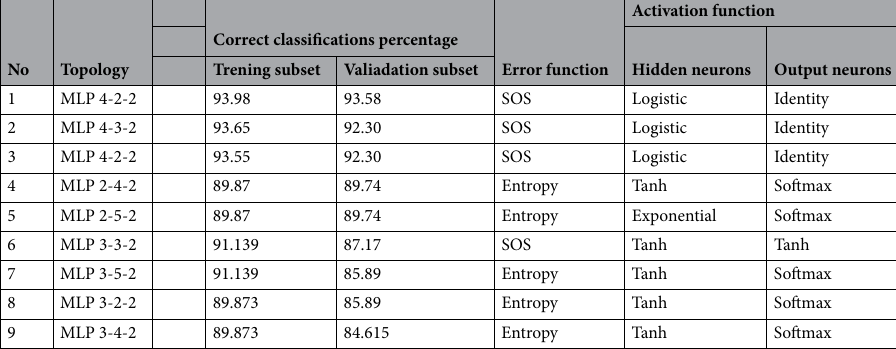
Table 7. Best predictors for differentiation CHD patients infected with H. pylori from H. pylori negative healthy donors based on IR spectra and artificial neural networks.